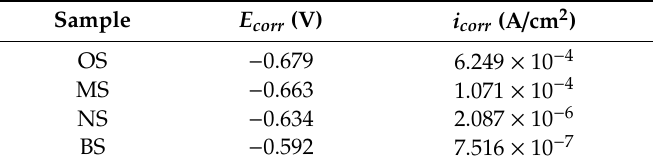
Figure 5. Electrochemical measurement of the OS, MS, NS, and BS in 3.5 wt.% NaCl solution. ( a ) Potentiodynamic polarization curves; ( b ) Bode plot ( | Z | changes as a function of frequency ranging from 1 to 10 5 Hz). Table 5. Parameters of potentiodynamic polarization curves for OS, MS, NS, and